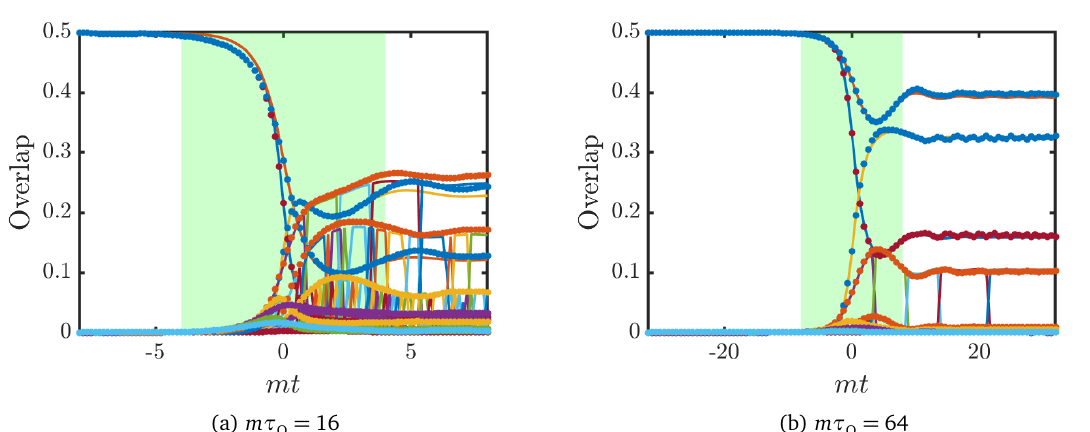
Figure 3.3: Overlaps of the evolving wave function with instantaneous eigenstates for two different ramps from the ferromagnetic to the paramagnetic phase with = 16 and m τ = 64 for mL = 50 ( m = − M m τ in terms of the initial mass). Q Q i The green region indicates the non-adiabatic regime. Solid lines are TCSA data for = 31 while dots are obtained from the numerical solution of the exact differen- N cut tial equations. Multiple pair states show several level